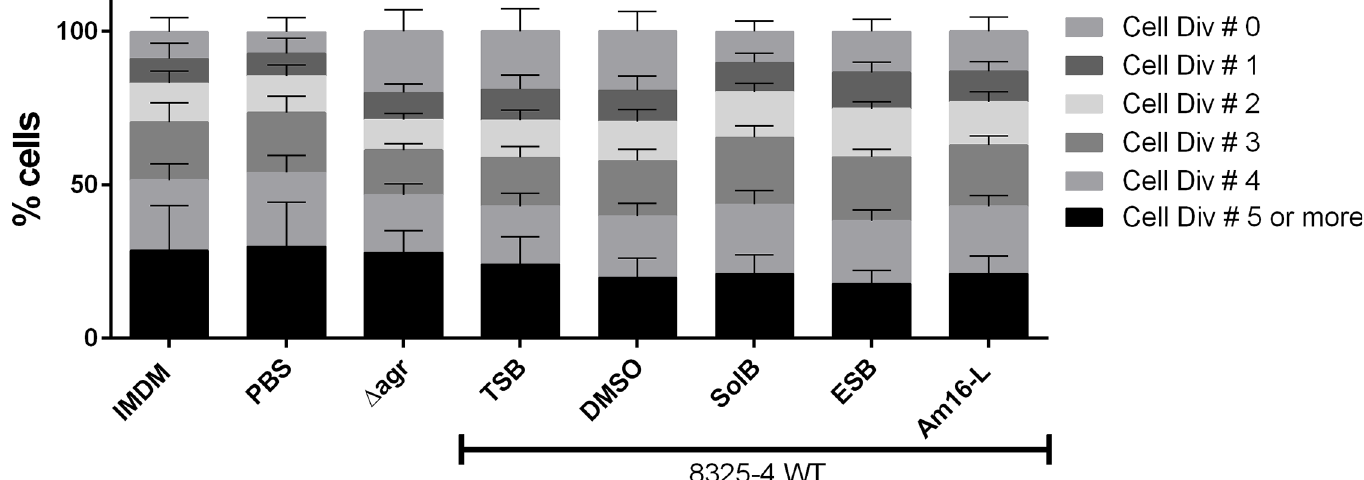
Fig 7. SolB, ESB and Am16-L- reduce interference of T-cell proliferation by S . aureus . CFDA/SE (25 μ g/mL) stained human PBMCs (1x10 6 /ml) were co- stimulated with aCD3/aCD28 (0.4ng and 0.024ng/mL respectively) and S. aureus either treated or not with 10 μ g/mL SolB, ESB or Am16-L at an MOI of 10 for 4 days. Harvested cells were stained with aCD4-PE and analyzed by Flow Cytometry using FACS Diva software. Lymphocytes were gated based on the expression of CD4, and the number of cell divisions was gated according to the CFDA/SE FITC excitation. The data represent the average of 3 donors, and the error bars represent the standard